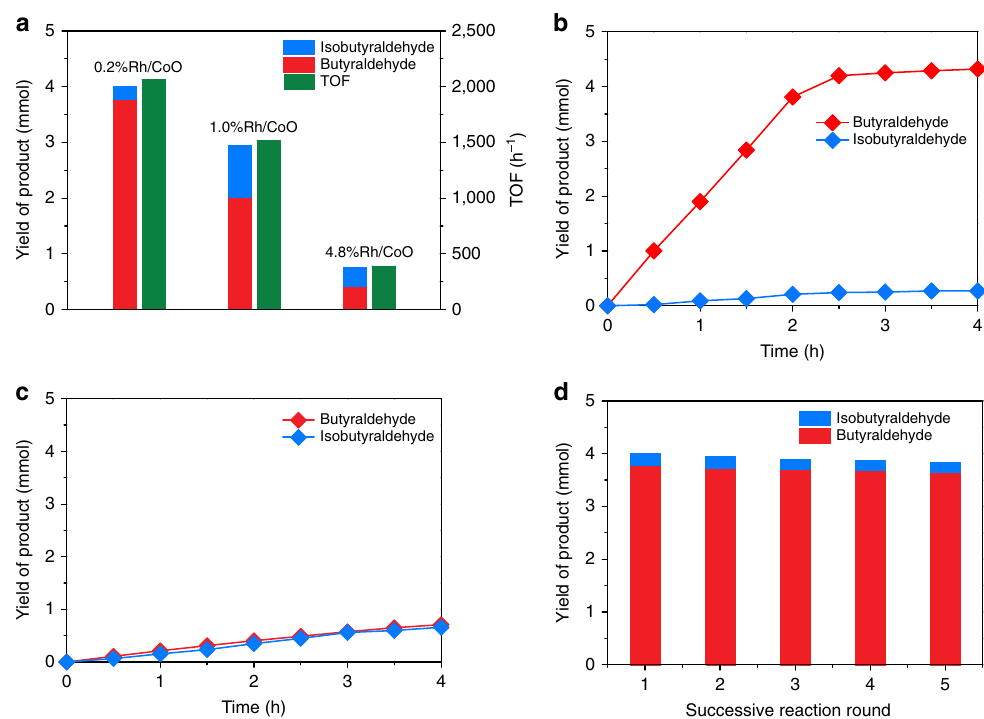
Figure 2 | Catalytic performance in the hydroformylation of propene. ( a ) TOFs and product yields of 0.2%Rh/CoO, 1.0%Rh/CoO, and 4.8%Rh/CoO in the hydroformylation of propene at 100 (cid:2) C after 2h. ( b , c ) Time courses of the hydroformylation of propene over 0.2%Rh/CoO and 4.8%Rh/CoO, respectively, at 100 (cid:2) C. ( d ) Product yields of 0.2%Rh/CoO over the course of five rounds of successive